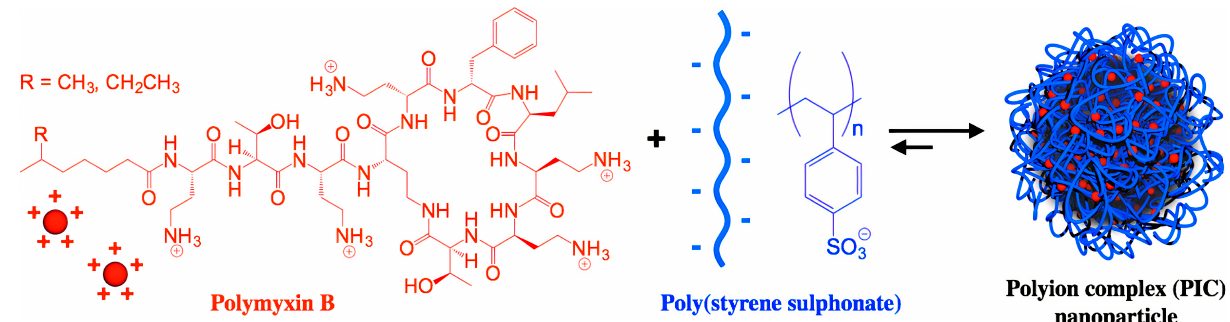
Figure 5. Nanoparticles of polymyxin B and poly (styrene sulphonate) active against Pseudomonas aeruginosa . Reprinted with permission from [90]. Copyright 2017 Elsevier.